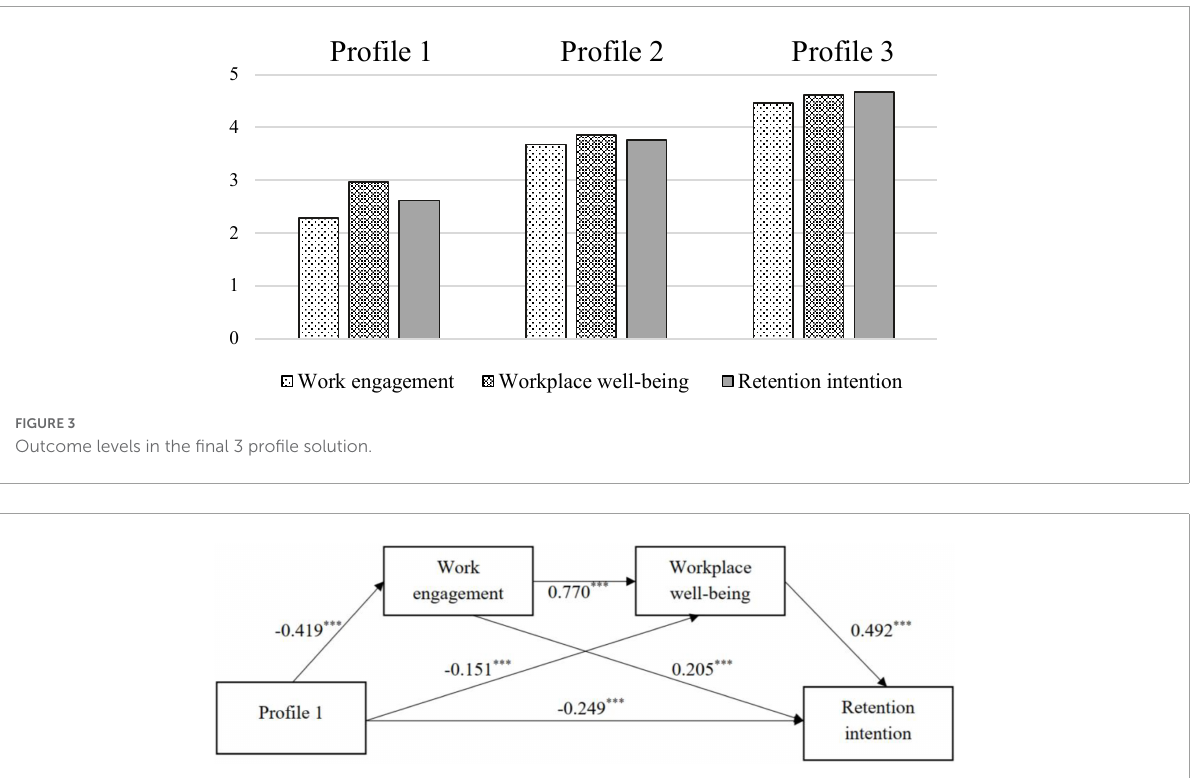
FIGURE4 Mediating role of work engagement and workplace wellbeing in the association between “low motivation-high cost” (profile 1) and retention intention. Moderate all (profile 2) was the reference group of kindergarten teacher motivation profiles. Unstandardized path coefficients were reported.